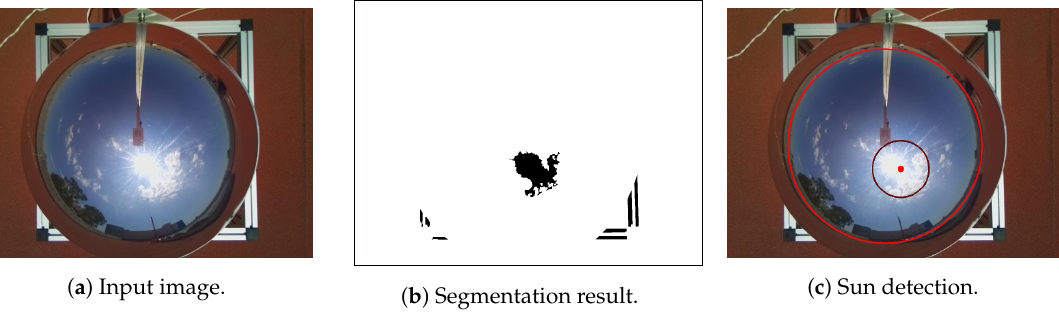
Figure 7. Sun and cloud segmented as a single object. ( b ) shows the output of the segmentation process, while in ( c ), the resulting Sun position (red dot), as well as the enclosing circle are